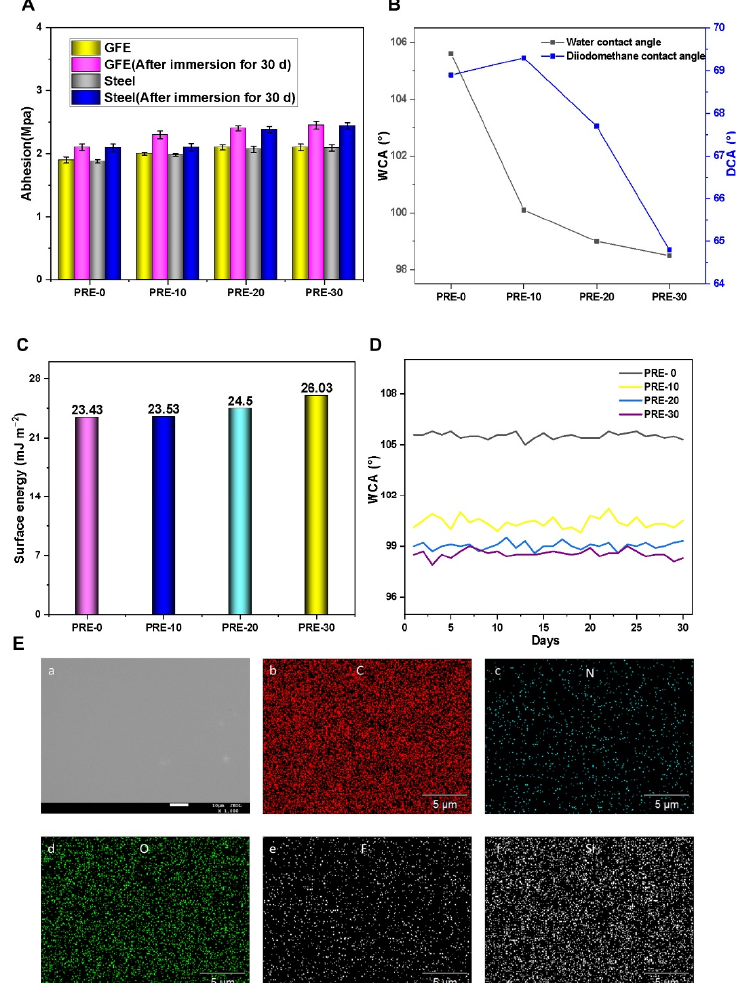
Figure 3. ( A ) Adhesion test results of coatings on Steel and GFE (Glass fiber reinforced epoxy resin) ( B ) WCA (Water contact angle) and DCA (Diiodomethane contact angle) for coating ( C ) Surface energy of the coating. ( D ) Contact angle of the coating immersed in water daily for 30 days. ( E ) (a) SEM analysis; (b–f) EDS mapping images of the PRE-20.